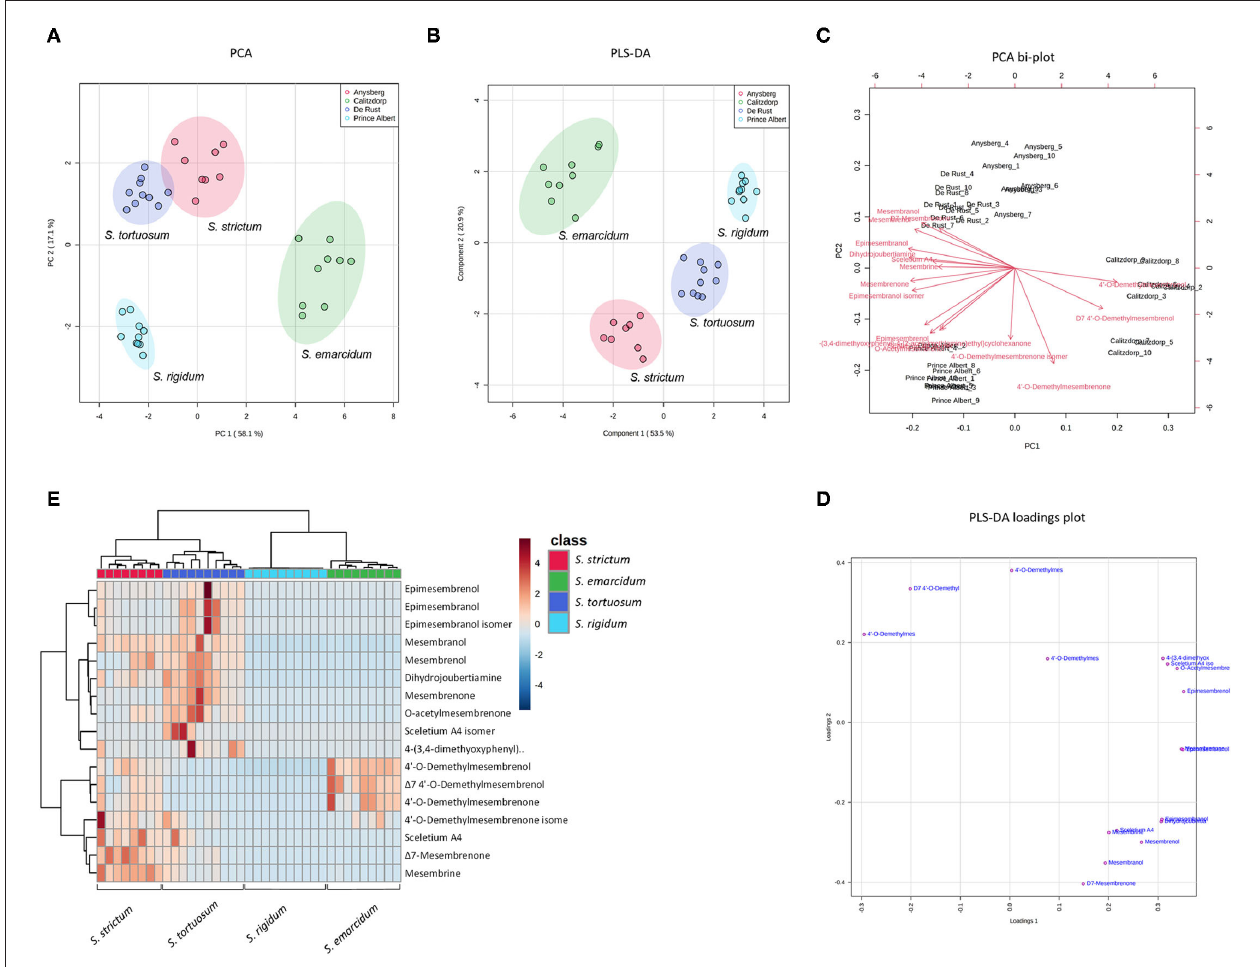
FIGURE 4 | (A) PCA on four species of Sceletium . ( S. rigidum; S. emarcidum; S. tortuosum and S. strictum ); (B) Supervised PLS-DA on four species of Sceletium ; (C) PCA bi-plot of phytochemicals contributing to separation among four species of Sceletium ; (D) PLS-DA loadings plot of phytochemicals contributing to the separation; (E) Heat map of phytochemical distribution among four Sceletium species generated using selected chemical